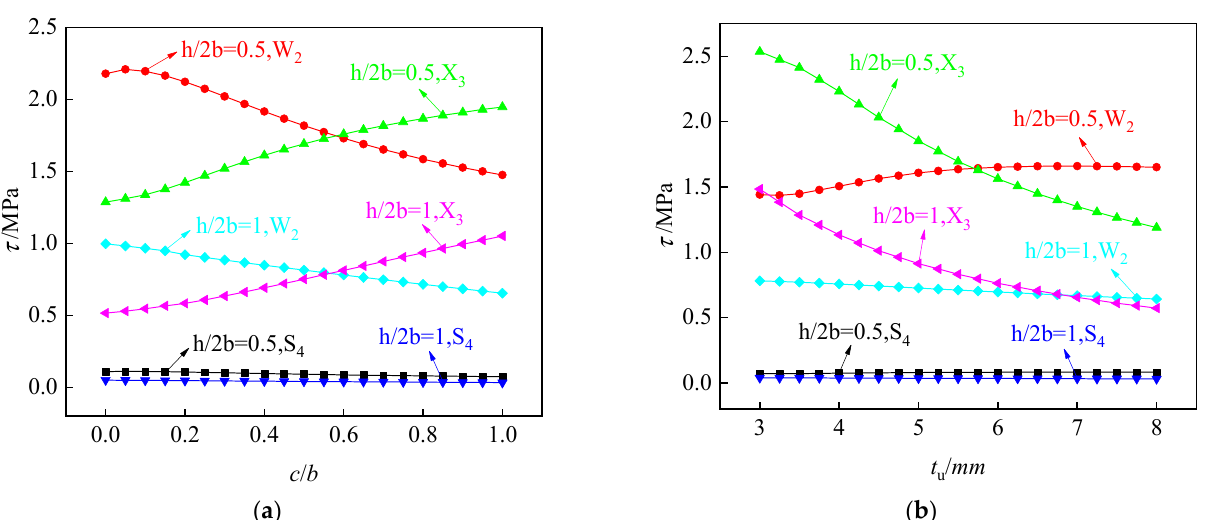
Figure 13. Total shear stress: ( a ) the width ratio of the cantilever plate; ( b ) the thickness of the bot- tom steel flange. steel flange.